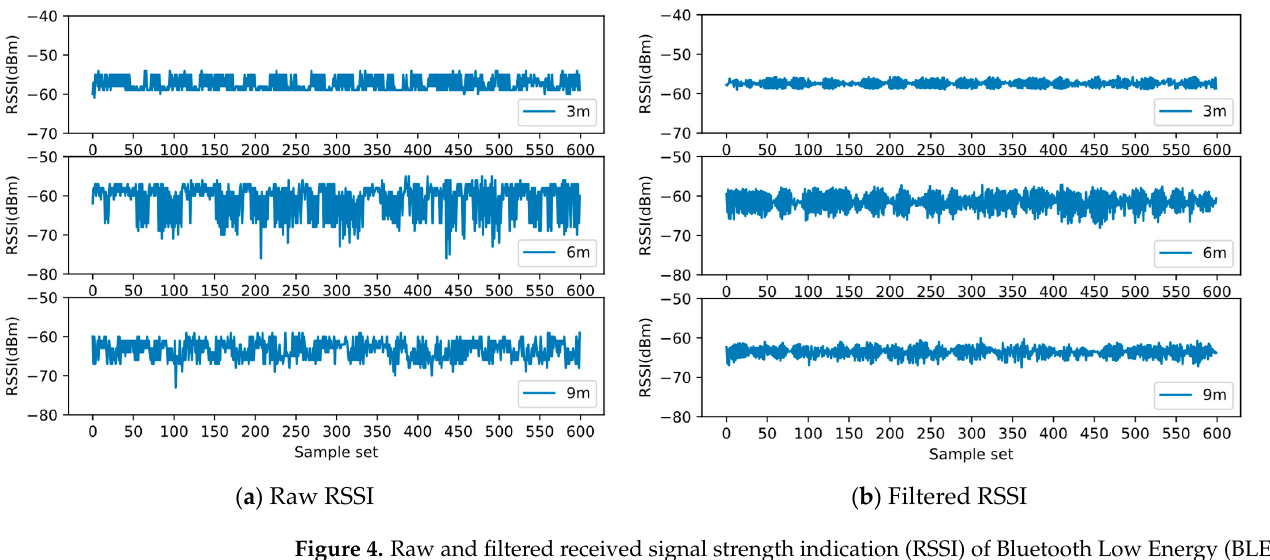
Table 1. Standard deviation (SD) of received signal strength indication (RSSI) at 3, 6, and 9 m before and after filtering.